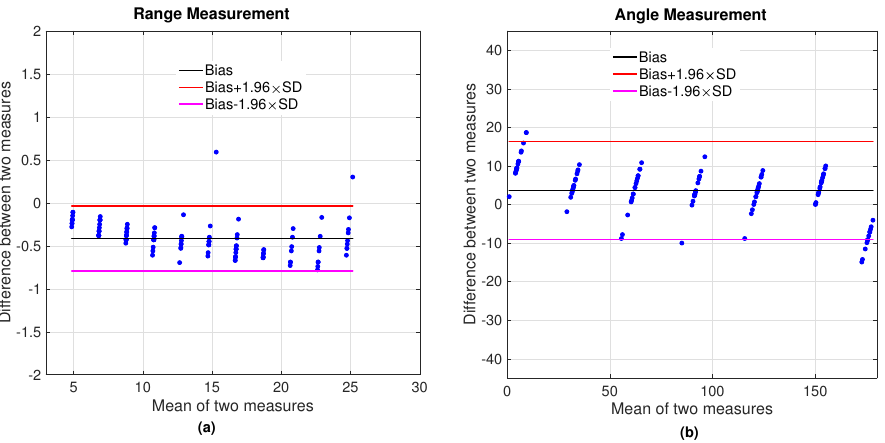
Figure 12. Bland-Altman Plot and their statistical parameters showing the agreement between actual and measured values of range and